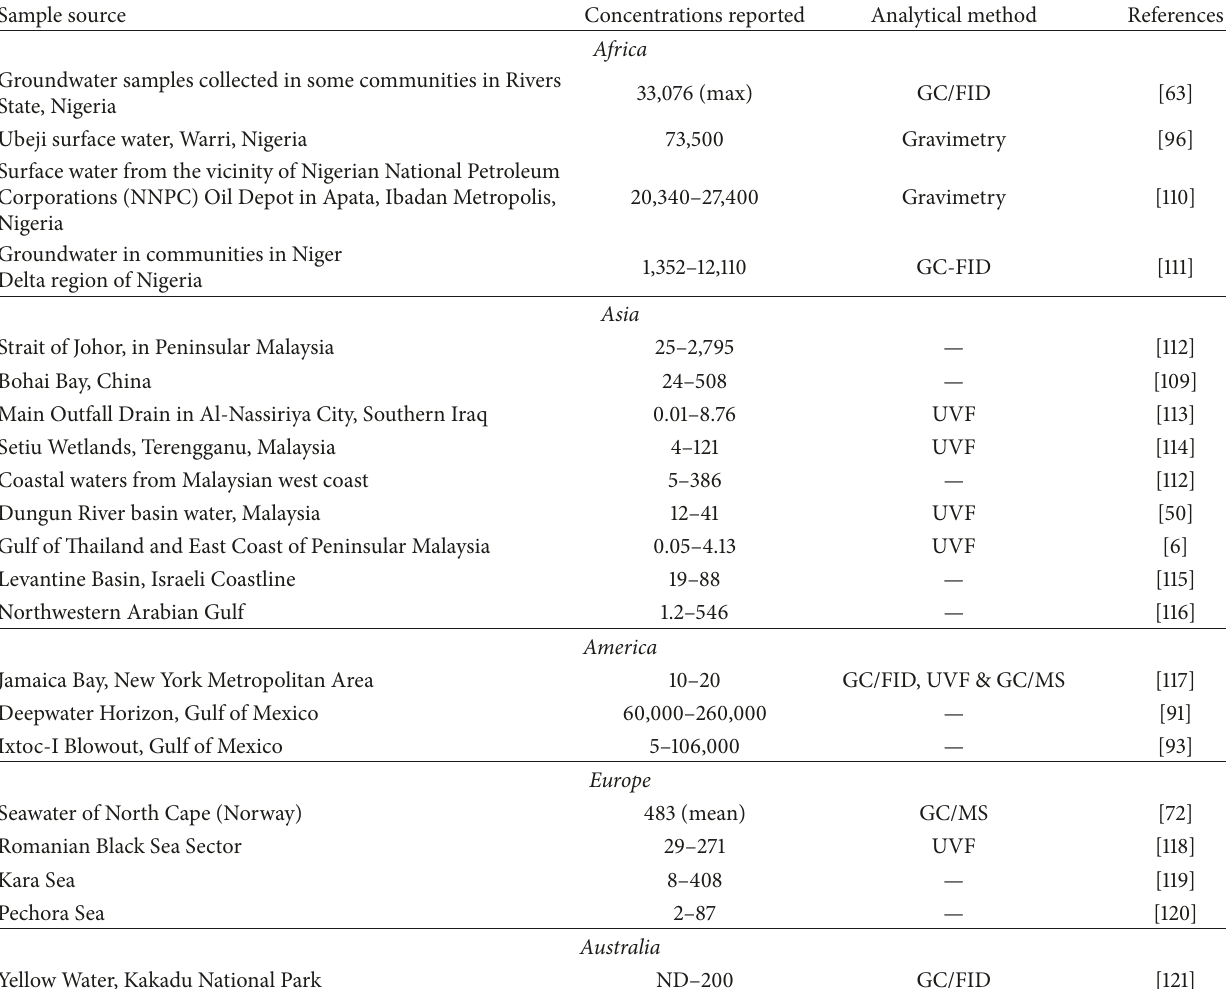
Table 1: Levels of TPHC in water samples around the world ( 𝜇